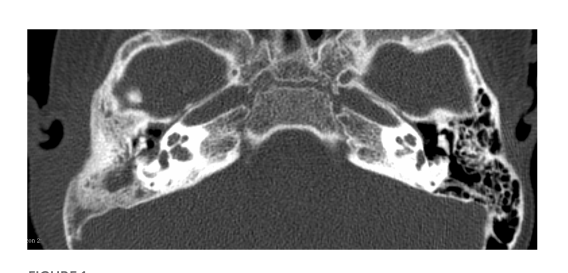
FIGURE1 LCH of the temporal bone. The bone has not been destroyed.